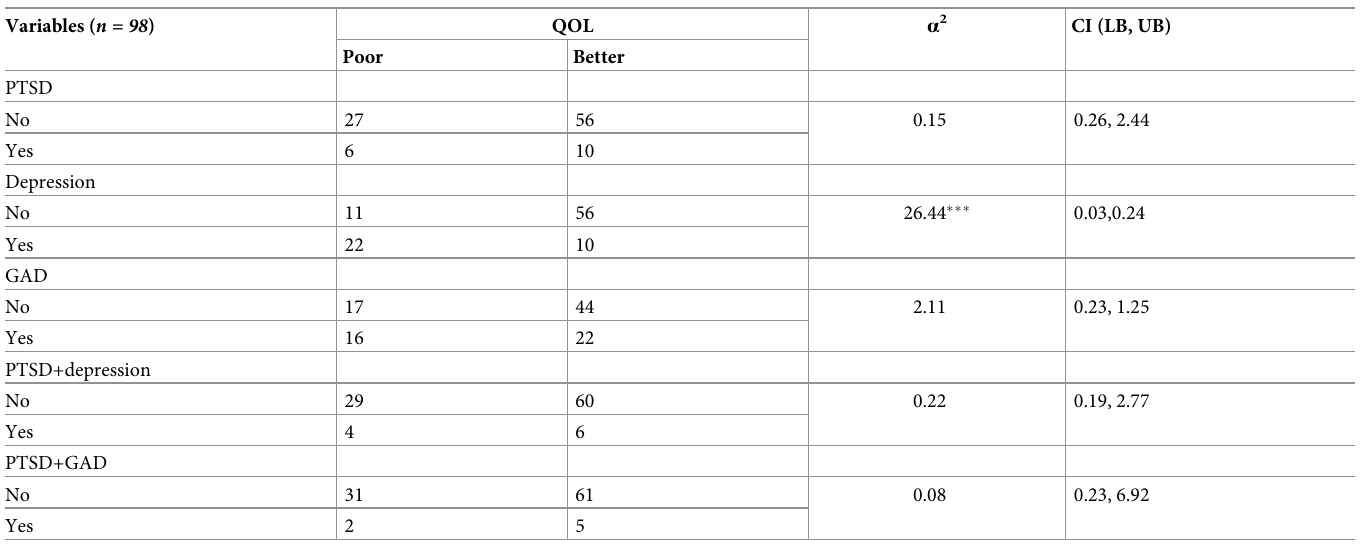
Table 3. Psychiatric disorders and QOL.